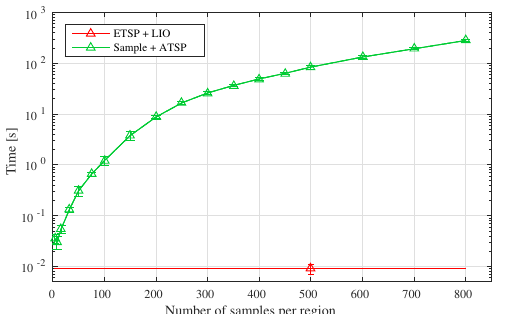
Figure 1. The average required computational time (from 20 trials) for the instance of the DTSPN with 4 circle regions and D 4